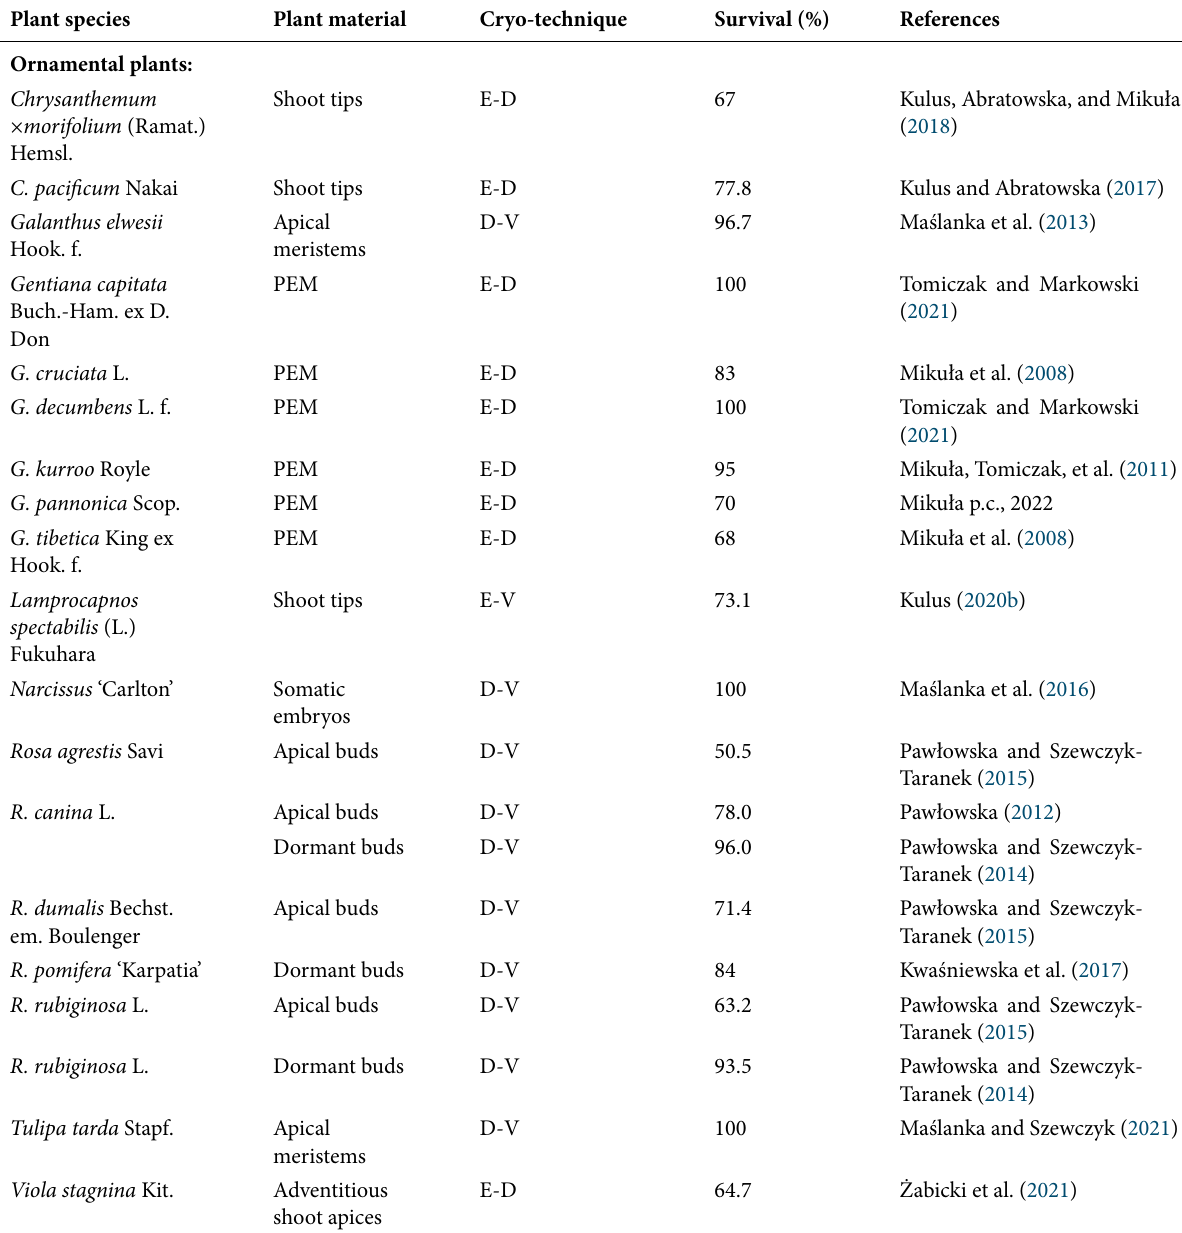
Table 3 Plant species for which cryopreservation protocols of tissues have been developed in Polish laboratories. Plant species Plant material Cryo-technique Survival